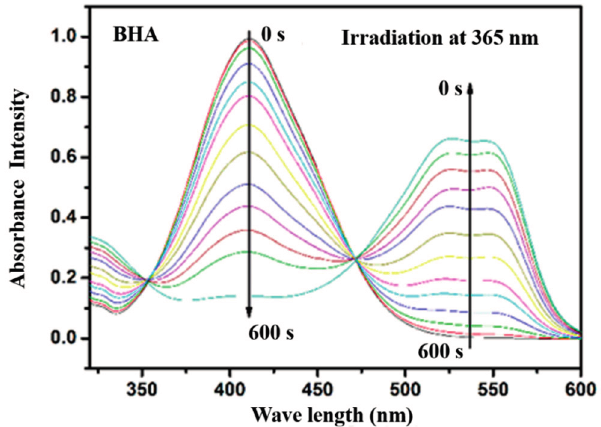
Figure 10. The UV-vis absorption changes of BHA during the irradiation with 365 nm UV light in chloroform solution (The concentration of azobenzene moieties is 5.00 × 10 − 5 M at room temperature). The arrows means that the time go on and the absorbance intensity decreased or increased.